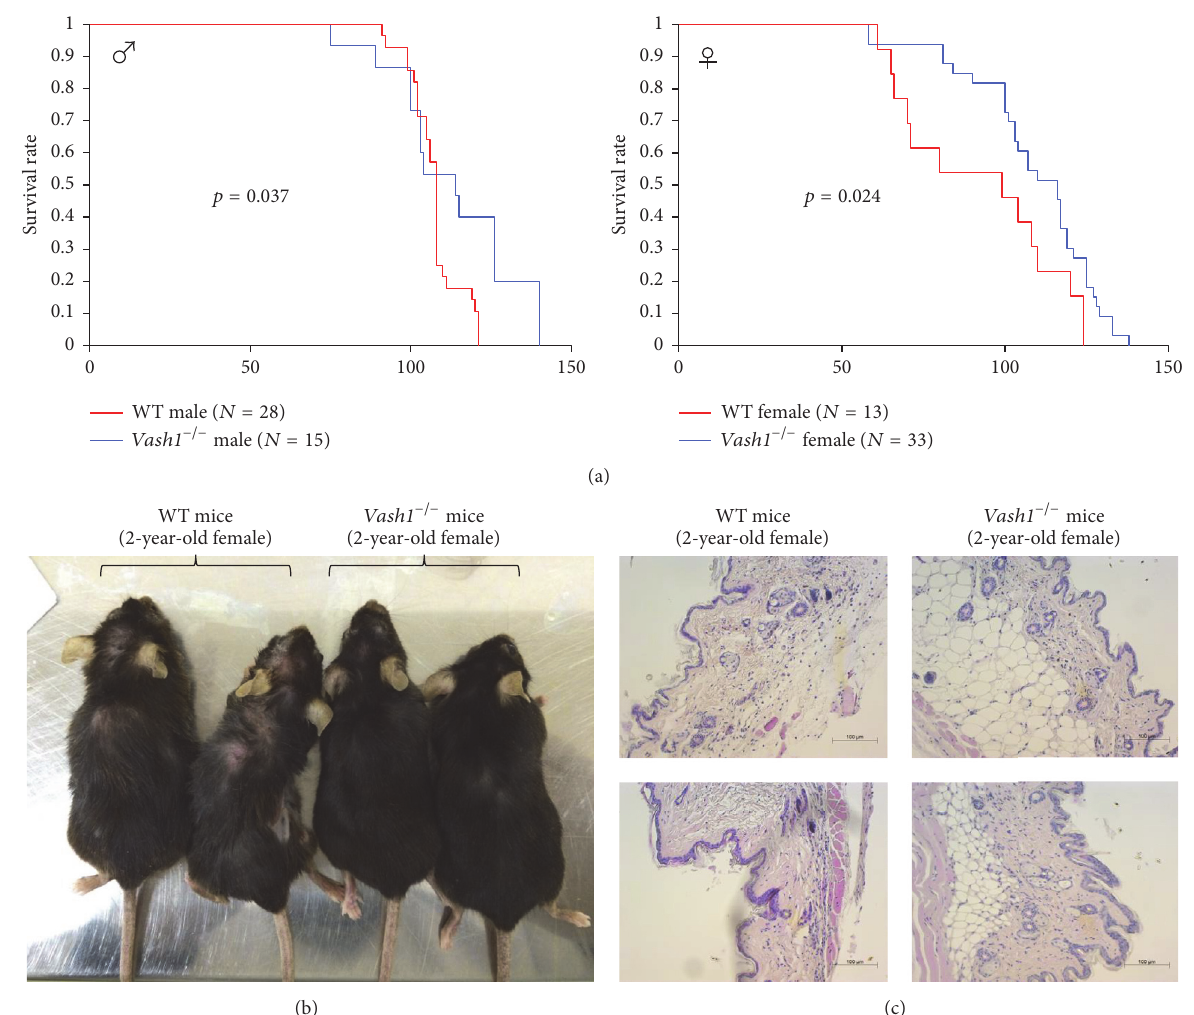
Figure 1: Healthy longevity of vash1 −/− mice of both genders. (a) WT and vash1 −/− mice of either gender were fed normal chow and compared for their survival rate. (b) Gross appearance of 2-year-old female WT and vash1 −/− mice is shown. (c) Subcutaneous tissues from 2-year-old female WT and vash1 −/− mice, stained with hematoxylin and